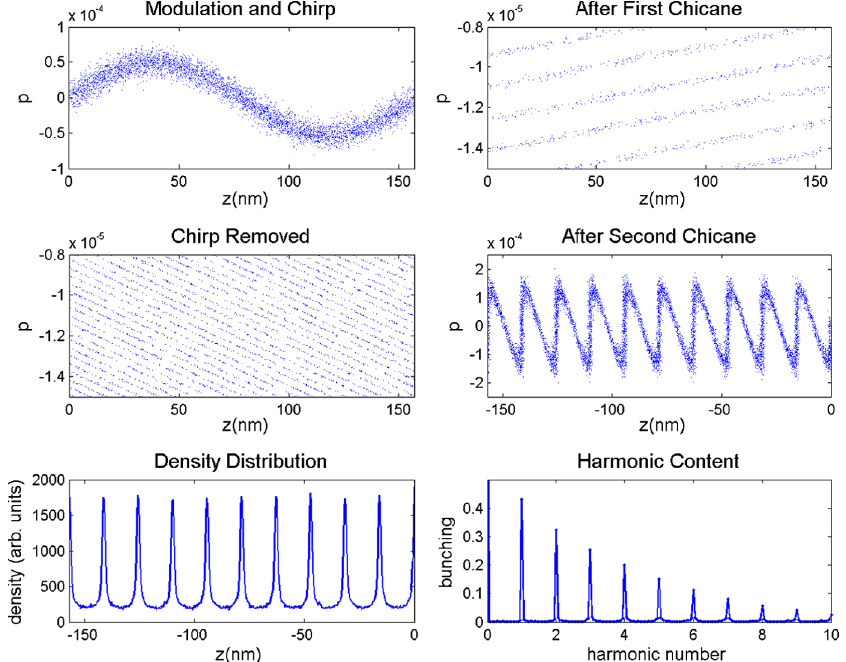
FIG. 2. In the first step (upper left) we add a chirp and laser modulation. We show only one modulation wavelength, so the chirp effect is small. After the first chicane, the modulation is overbunched (zoom, upper right). A second chirp reverses the first chirp (zoom, middle left, shows reversed slope in phase space). After more acceleration, the second chicane revives bunching (middle right). Note the compression of the wavelength by j (cid:1) j ¼ 10 , and the increase in modulation amplitude by j (cid:1) j =g ¼ 2 : 5 . We find strong bunching past the 5th harmonic